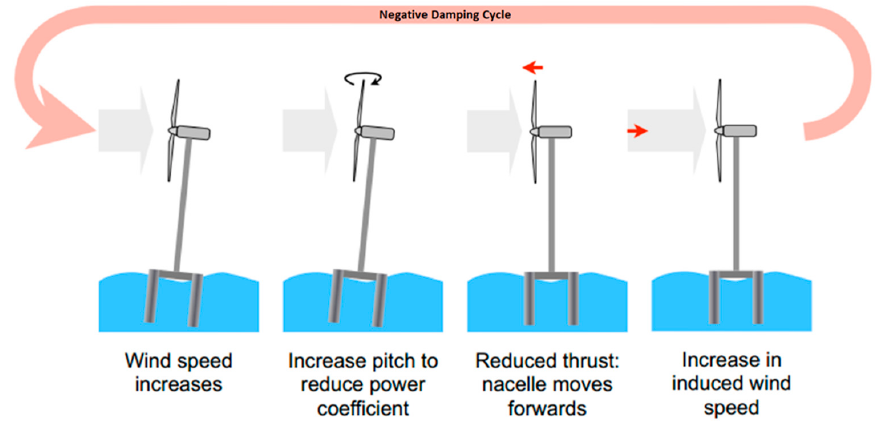
Figure 1. Tower oscillation propagation in a pitch-to-feather horizontal axis wind turbine (HAWT) due to the negative damping cycle. Adapted from Reference [4] Reprinted with permission [van der Veen]; 2012, American Control Conference.